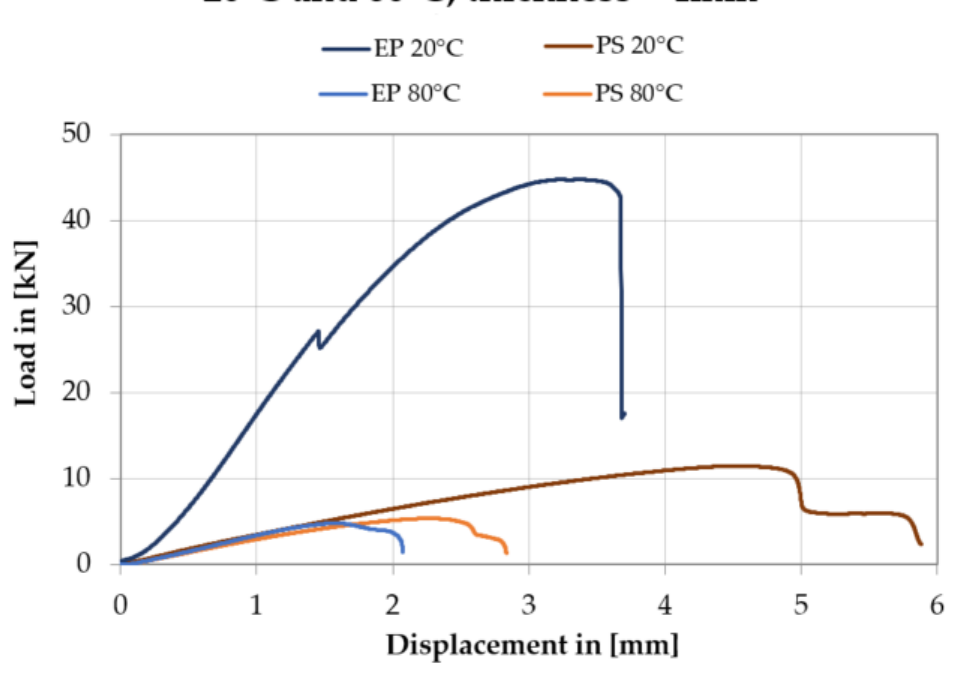
Figure 16. Force vs. displacement plots for Sika ® PS and EP 2579-1 adhesives with the thickness t = 4 mm, at temperature 20 °C and 80 °C.